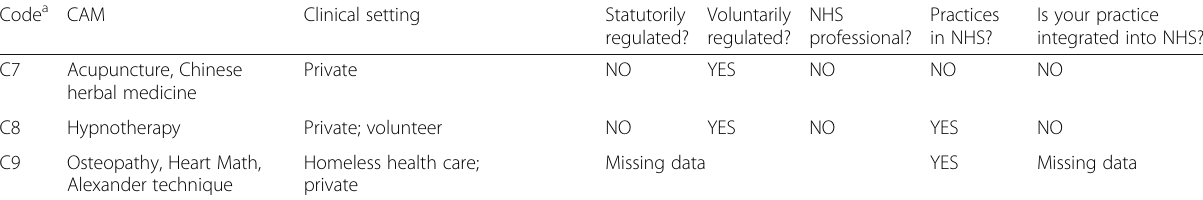
Table 1 Participants in CAM practitioner focus groups (Continued)